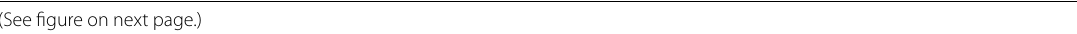
OLC group, n 8/group. + =